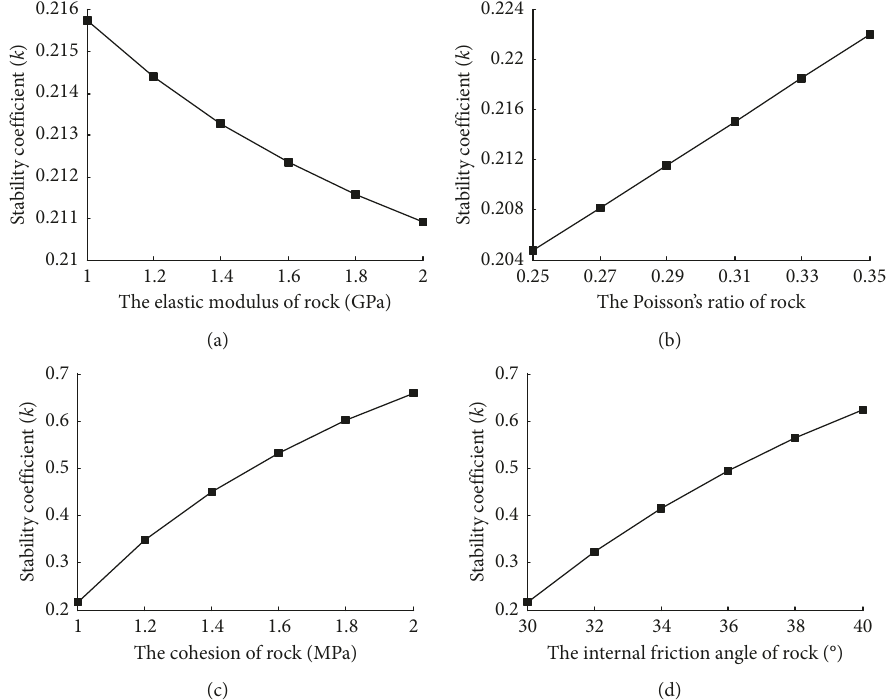
Figure 10: Influence of the rock’s physical-mechanical parameters on the stability of the surrounding rock: (a) elastic modulus; (b) Poisson’s ratio; (c) cohesion; (d) internal friction